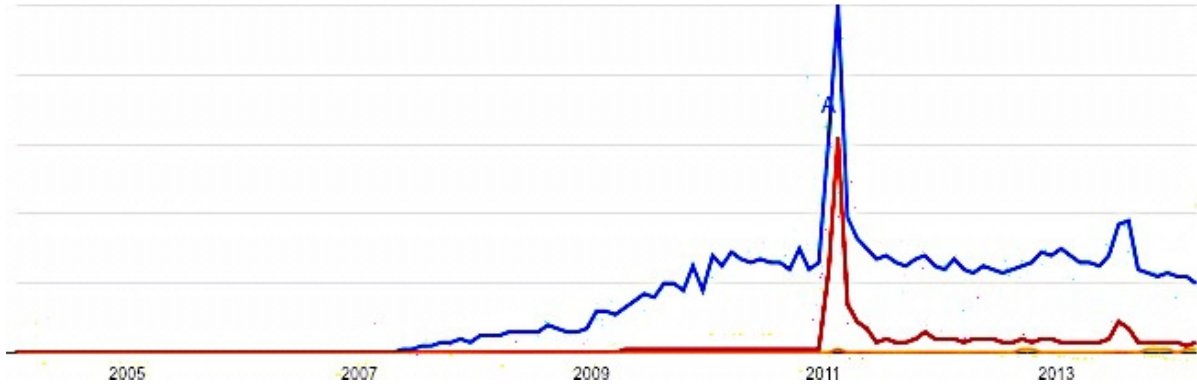
Figure 5. Dynamics of popularity of Facebook, Twitter and Google Docs (in descending order) in Ukraine by year. Source : Google Trends 2014.